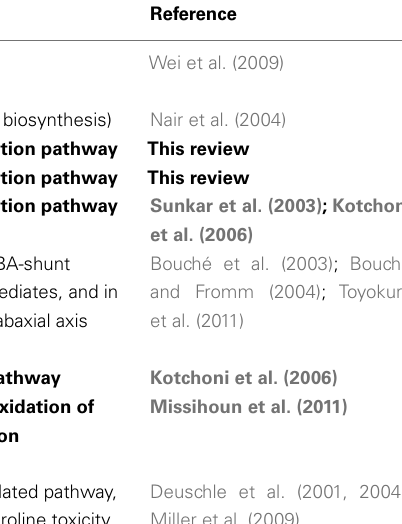
Table 1 | Localization and putative physiological functions of the Arabidopsis thaliana ALDH protein superfamily. Protein Locus